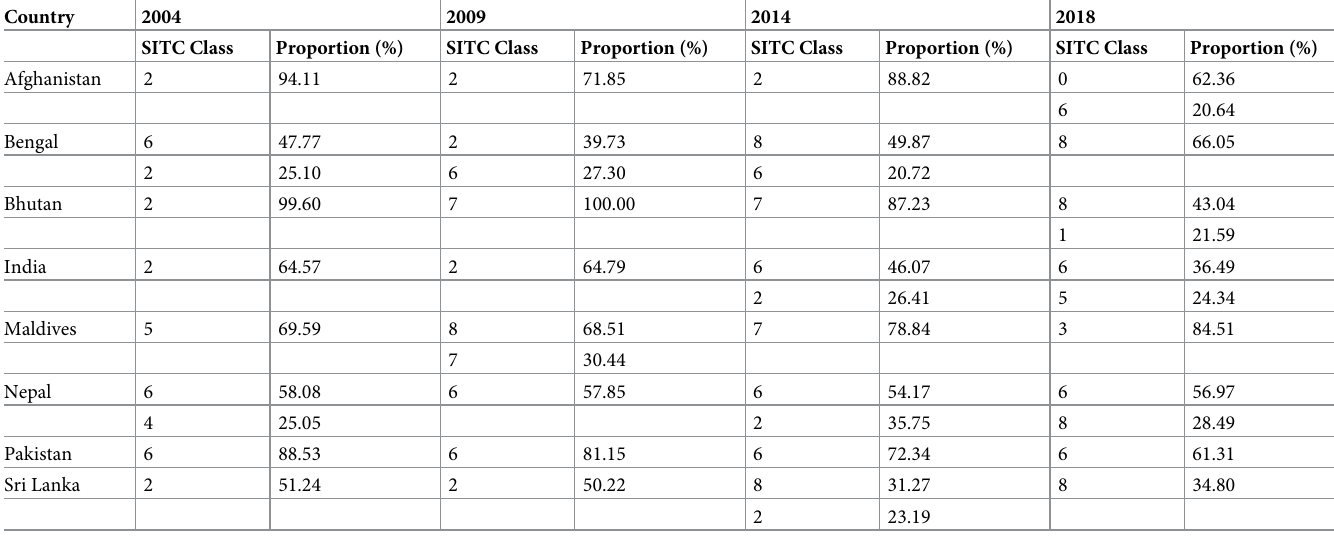
Table 3. The structure of China’s imports from South Asia countries. Country